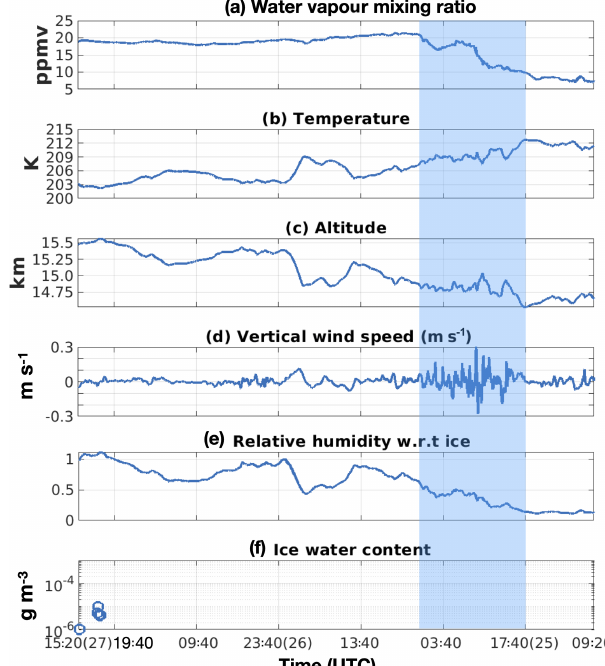
Figure 8. The changes of the properties of a tracked air parcel (red circle highlighted in Fig. 7) along its back and forward trajectory. The beginning time of the back and forward tracing is 19:40UTC, 27 August. Highlighted in the rectangular shaded area is the en- countering of the air parcel with the overshooting convections in Domain A at around 22:40UTC, 25 August, which is shown by fast-rising water vapour concentration, decrease in temperature, rise in altitude and sudden changes in vertical wind